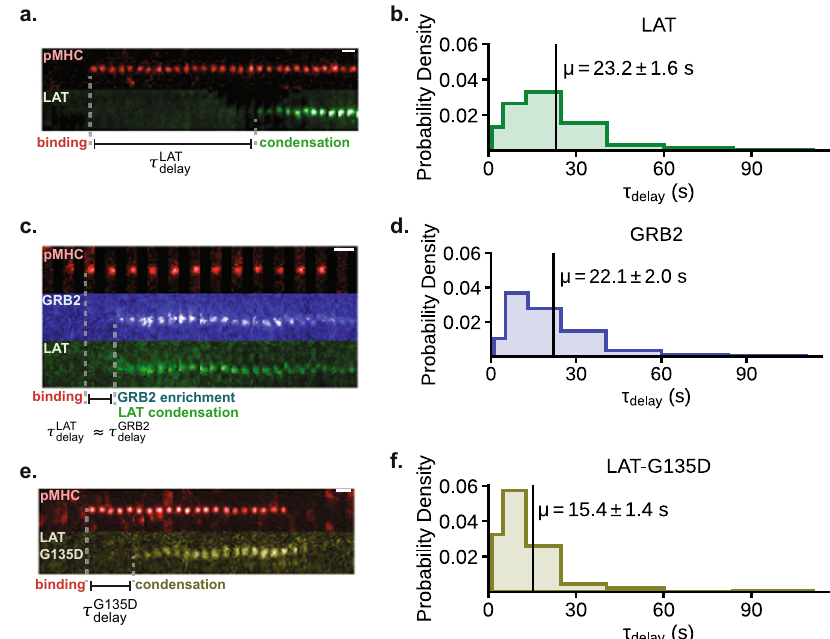
Fig.4|LATcondensationoccursafteranextendeddelay. PrimarymouseTcells expressing different constructs were deposited onto bilayers with 0.1 – 0.2molecules μ m − 2 of MCC(Atto647) pMHC. For the histograms,